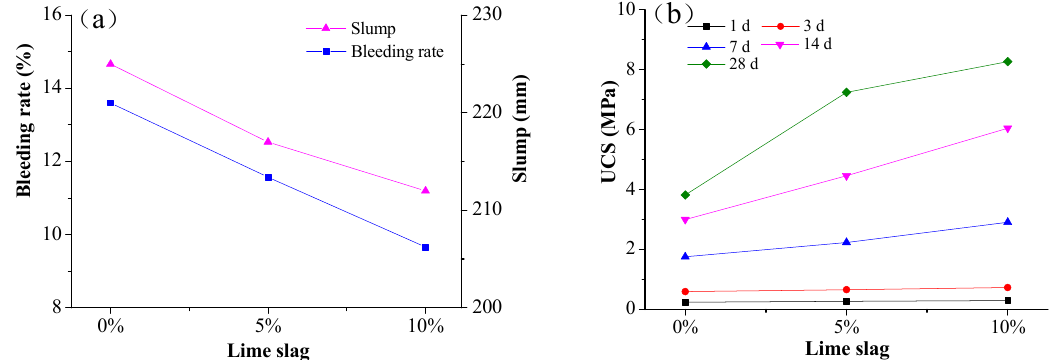
Figure 11. Effects of LS content on properties of filling material: ( a ) effects of LS content on transportation properties of filling material; ( b ) effects of LS content on mechanical properties of filling material.